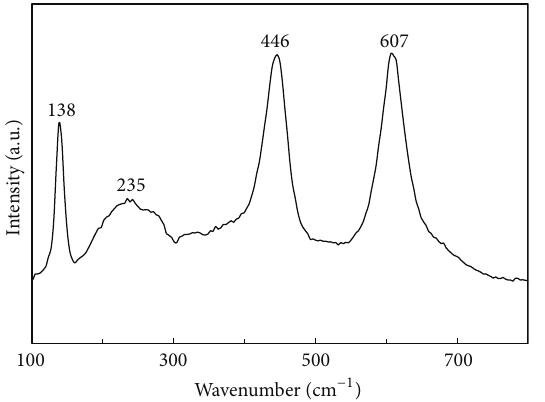
Figure 4: Raman spectrum of the surface of the porous TiO 2 -coated a-silica glass tube.